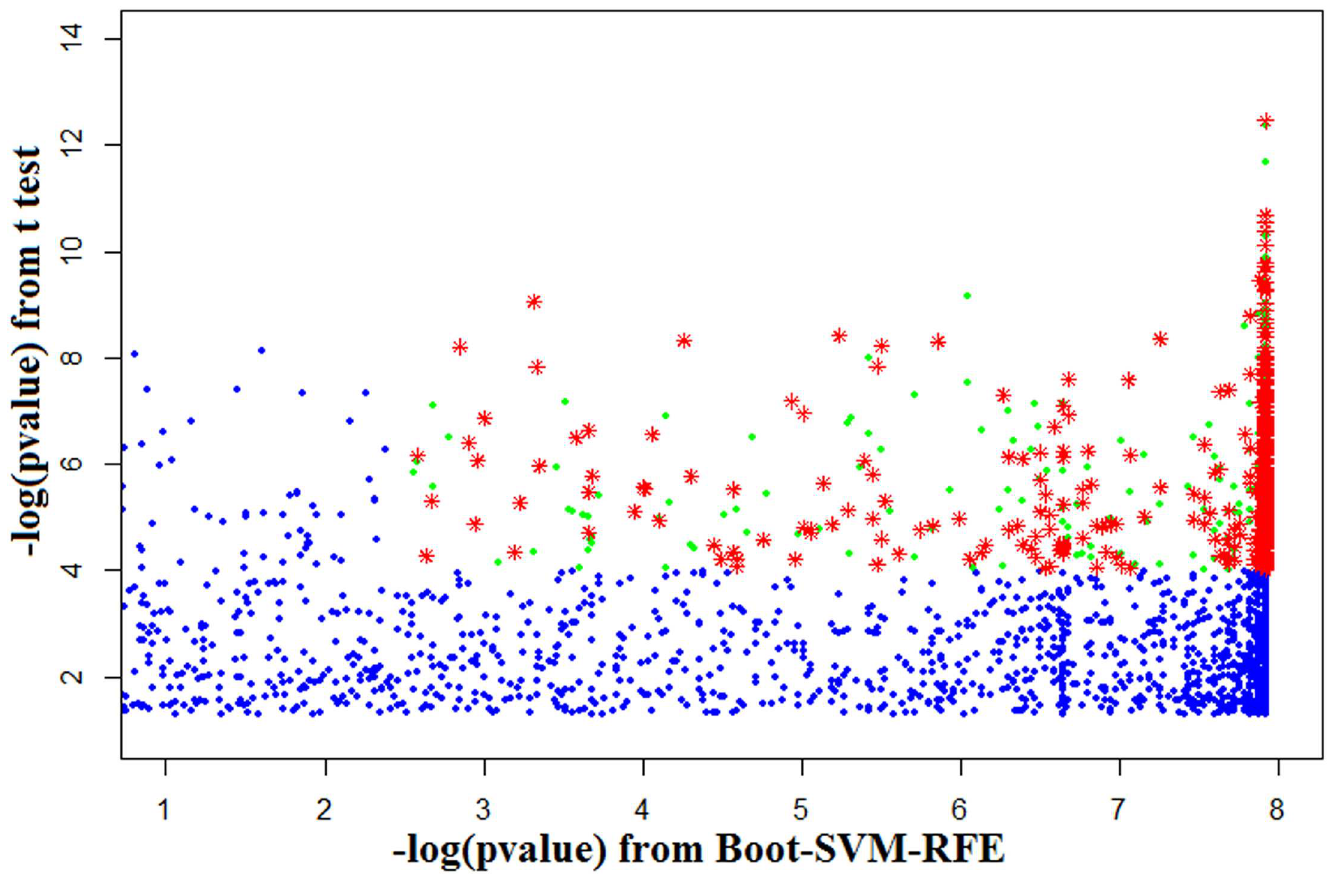
Fig 1. Gene selection plot for selection of informative genes for Al stress in soybean. The horizontal axis represents negative logarithmof statistical significance values obtained from Boot-SVM-RFE. The vertical axis shows the negativelogarithmof statistical significancevalues from t-test. Green dots indicateselectedprobes with–log( p-value )from Boot-SVM-RFE (cid:21) thresholdof 2.5 and t-test–log ( p-value ) (cid:21) thresholdof 4. Red stars indicate the selectedprobeswhich have Arabidopsis orthologs. Blue dots indicate unselectedprobes.